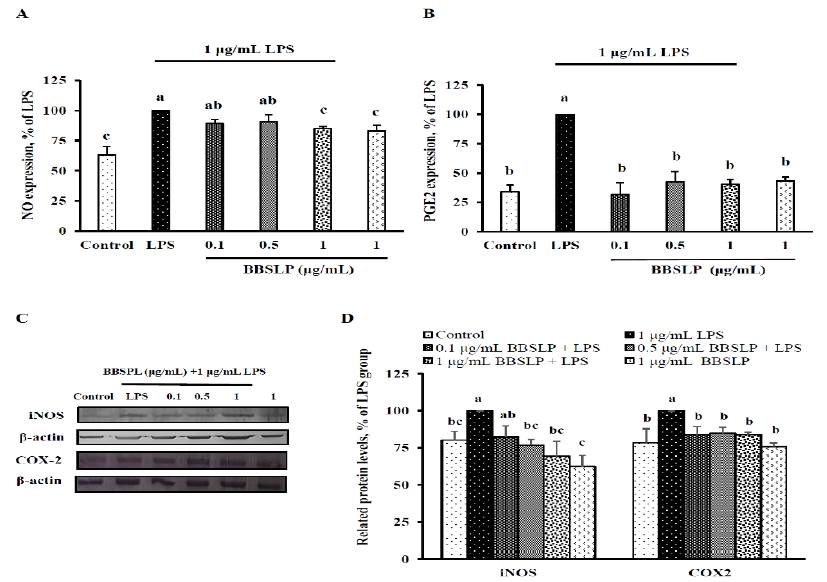
Figure 4. Effects of BBSLP on NO, PGE 2 , iNOS and COX-2 levels in RAW264.7 cells induced by LPS. 5 cells/30-mm plate) were seeded and cultured overnight, treated with RAW264.7 cells (1 × 10 5 cells/30-mm plate) were seeded and cultured overnight, treated with 0.1, 0.5 RAW264.7 cells (1 × 10